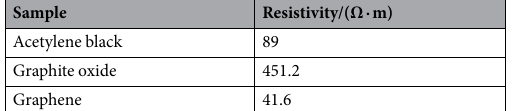
Table 2. Resistance of acetylene black, graphite oxide and